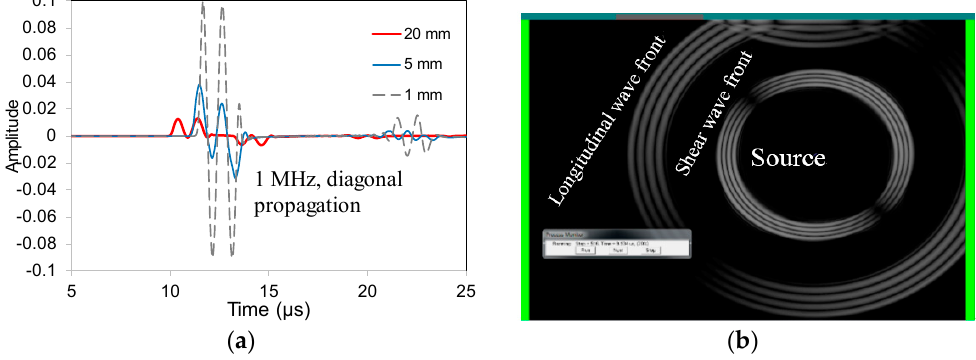
Figure 6. ( a ) Waveforms received by different size sensors for the case of diagonal source and frequency excitation of 1 MHz; ( b ) Snapshot of displacement field corresponding to 10 µs after excitation (exc. frequency at 1 MHz).